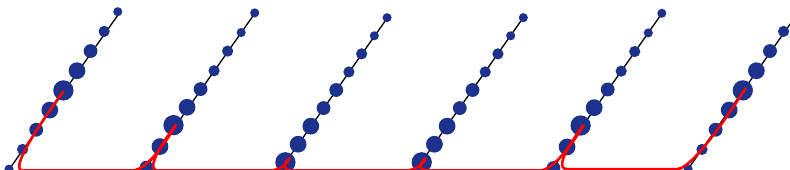
Figure 15: (Color online) Schematic representation of a state in a comb with odd ≈ 1. Spin-1 / 2 degrees of freedom are delocalized number of sites per tooth and J bb along the teeth in a non-uniform way, so the emergent spin-1 / 2 degrees of freedom are not equally spaced. This is effectively equivalent to the spin-1 / 2 chain with non- (cid:54) = const. uniform coupling constant J i